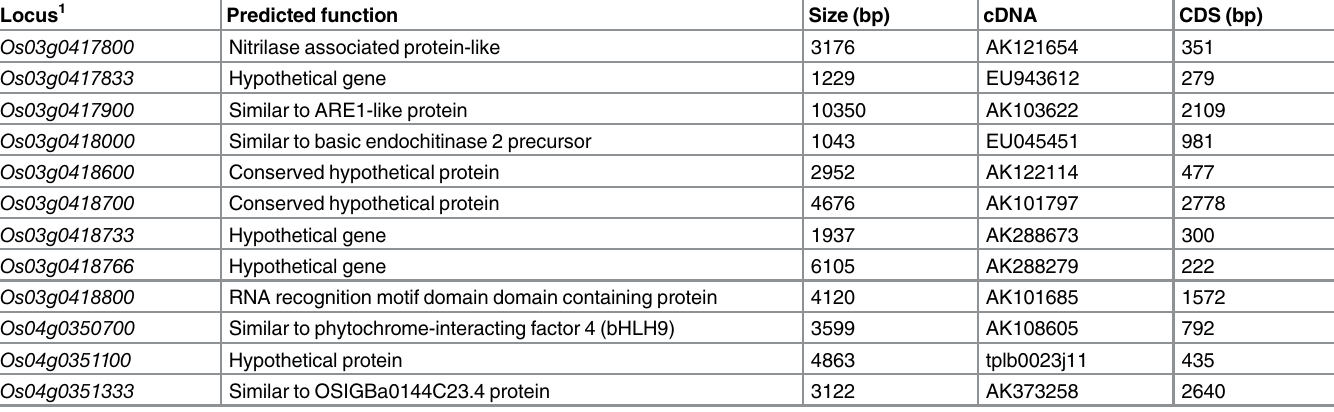
Table 3. Predicted genes in the finely mapped region of Awn3-1 and Awn4-2 . Locus